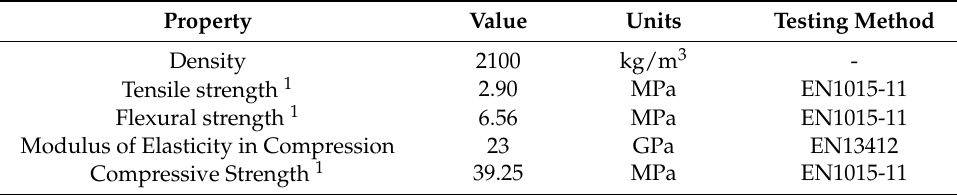
Table 3. The mechanical properties of Sika ® MonoTop-612 mortar. Property Value Units Testing Method Density 2100 kg/m 3 Tensile strength 1 2.90 Flexural strength 1 Modulus of Elasticity in